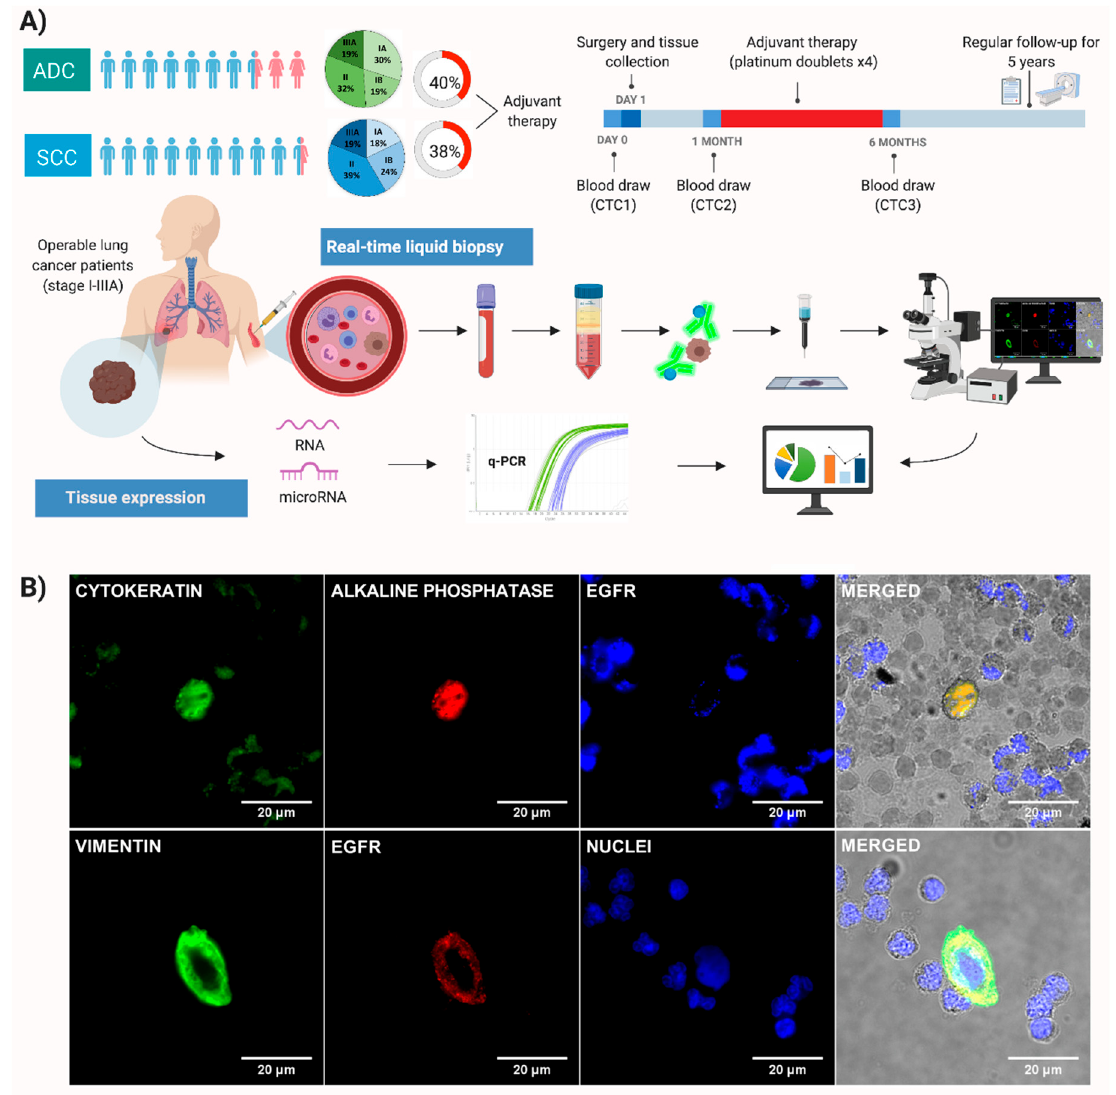
Figure 1. Study design and circulating tumor cell (CTC) characterization. ( A ) Patients enrolled and study design: this study included two cohorts, one of adenocarcinoma (ADC) and the other of squamous cell carcinoma (SCC) patients with similar distributions of gender, stage, and administered adjuvant treatment. Baseline blood sample (CTC1) was extracted before the surgery and tissue collection, one month after (CTC2), and six months later (CTC3) during adjuvant treatment in those susceptible cases (Credit: created with BioRender). ( B ) Immunofluorescence of CTC phenotype characterization in non-small cell lung cancer (NSCLC) patients: top row shows a cytokeratin-positive CTC (green and red staining) with epidermal growth factor receptor (EGFR) positive expression (blue). Bottom row represents an epithelial-to-mesenchymal transition (EMT) CTC with vimentin expression (green), EGFR positive expression (red), and DAPI—nuclei staining (blue). Images taken at 63× magnification in a Zeiss Epifluorescence Axio Imager A.1 microscope.